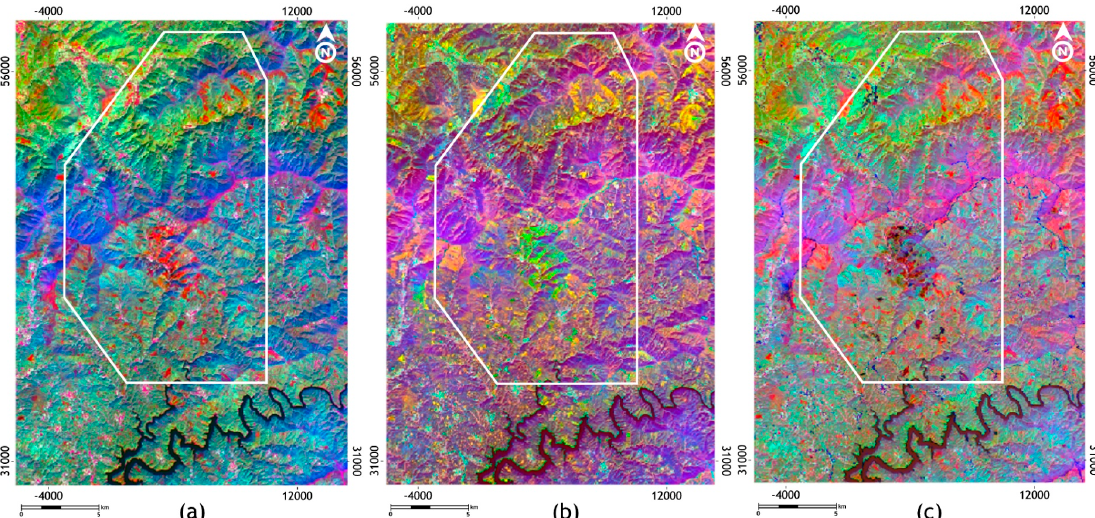
Figure 7. RGB colour composites using the first four Principal Components: ( a ) PC1-PC2-PC3; ( b ) PC4-PC1-PC3 and ( c ) PC4-PC2-PC3.